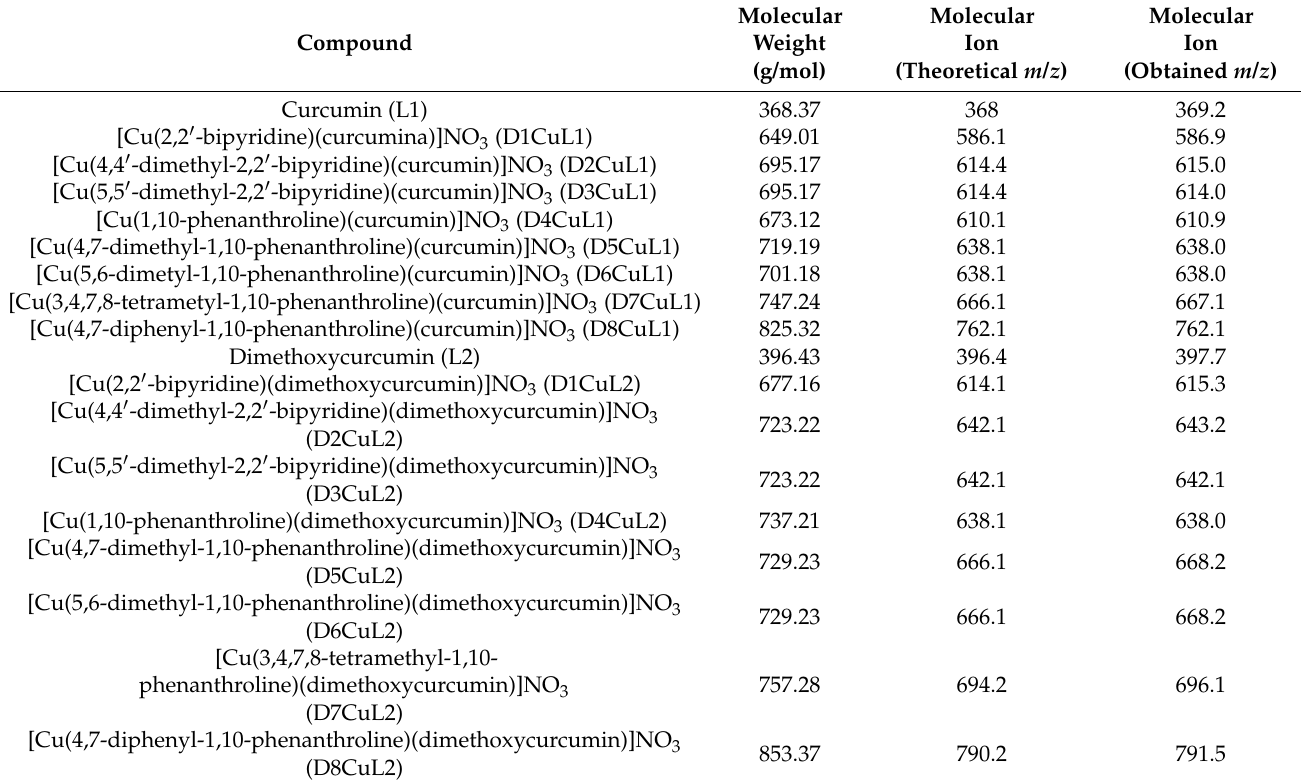
Table 2. Mass spectral data ( m / z ) of ligands and copper(II)